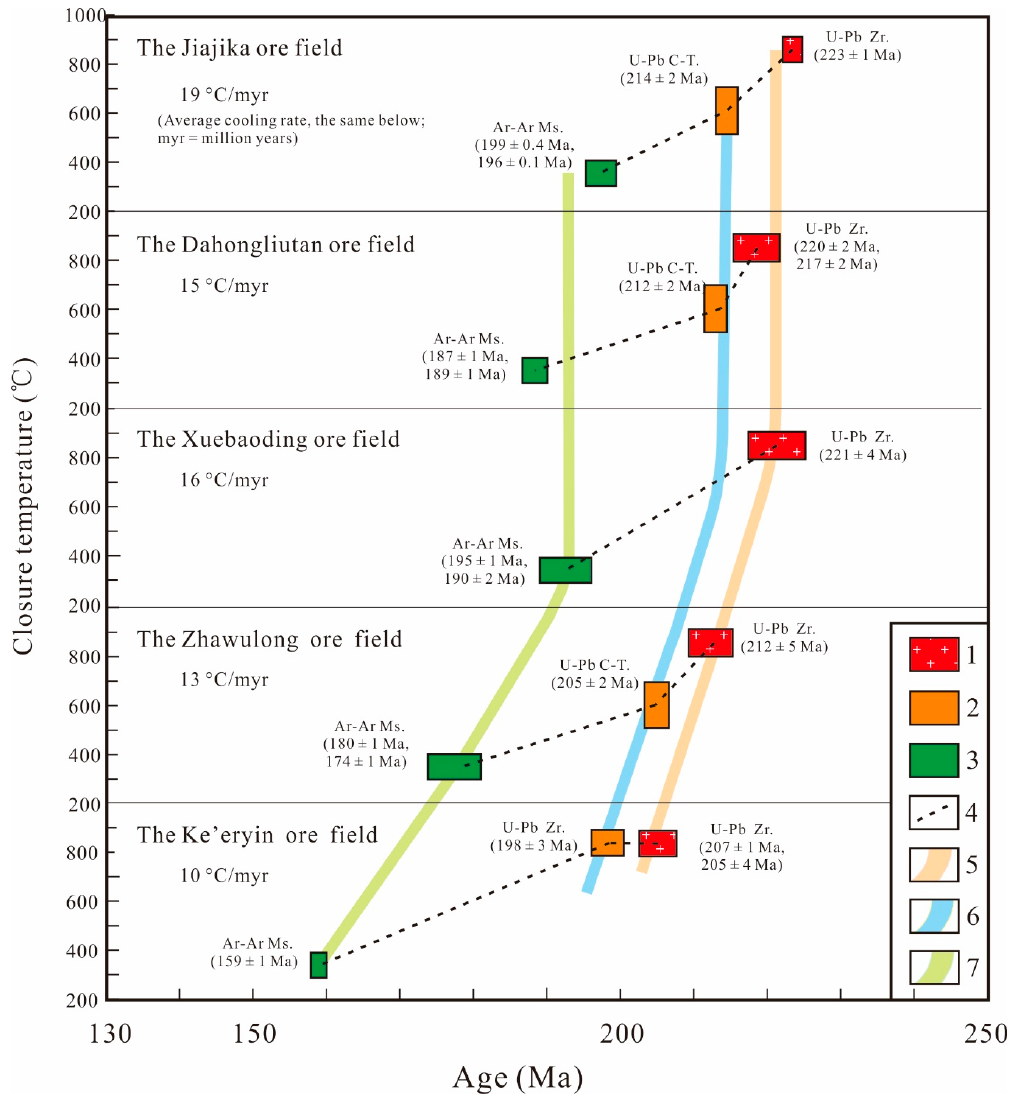
Figure 11. Cooling T–t paths in different areas of the Songpan–Ganzê orogenic belt, plotted from the closure temperatures of different isotope systems and the corresponding dating results. The widths and heights of rectangles represent the ranges in age and closure temperature, respectively.